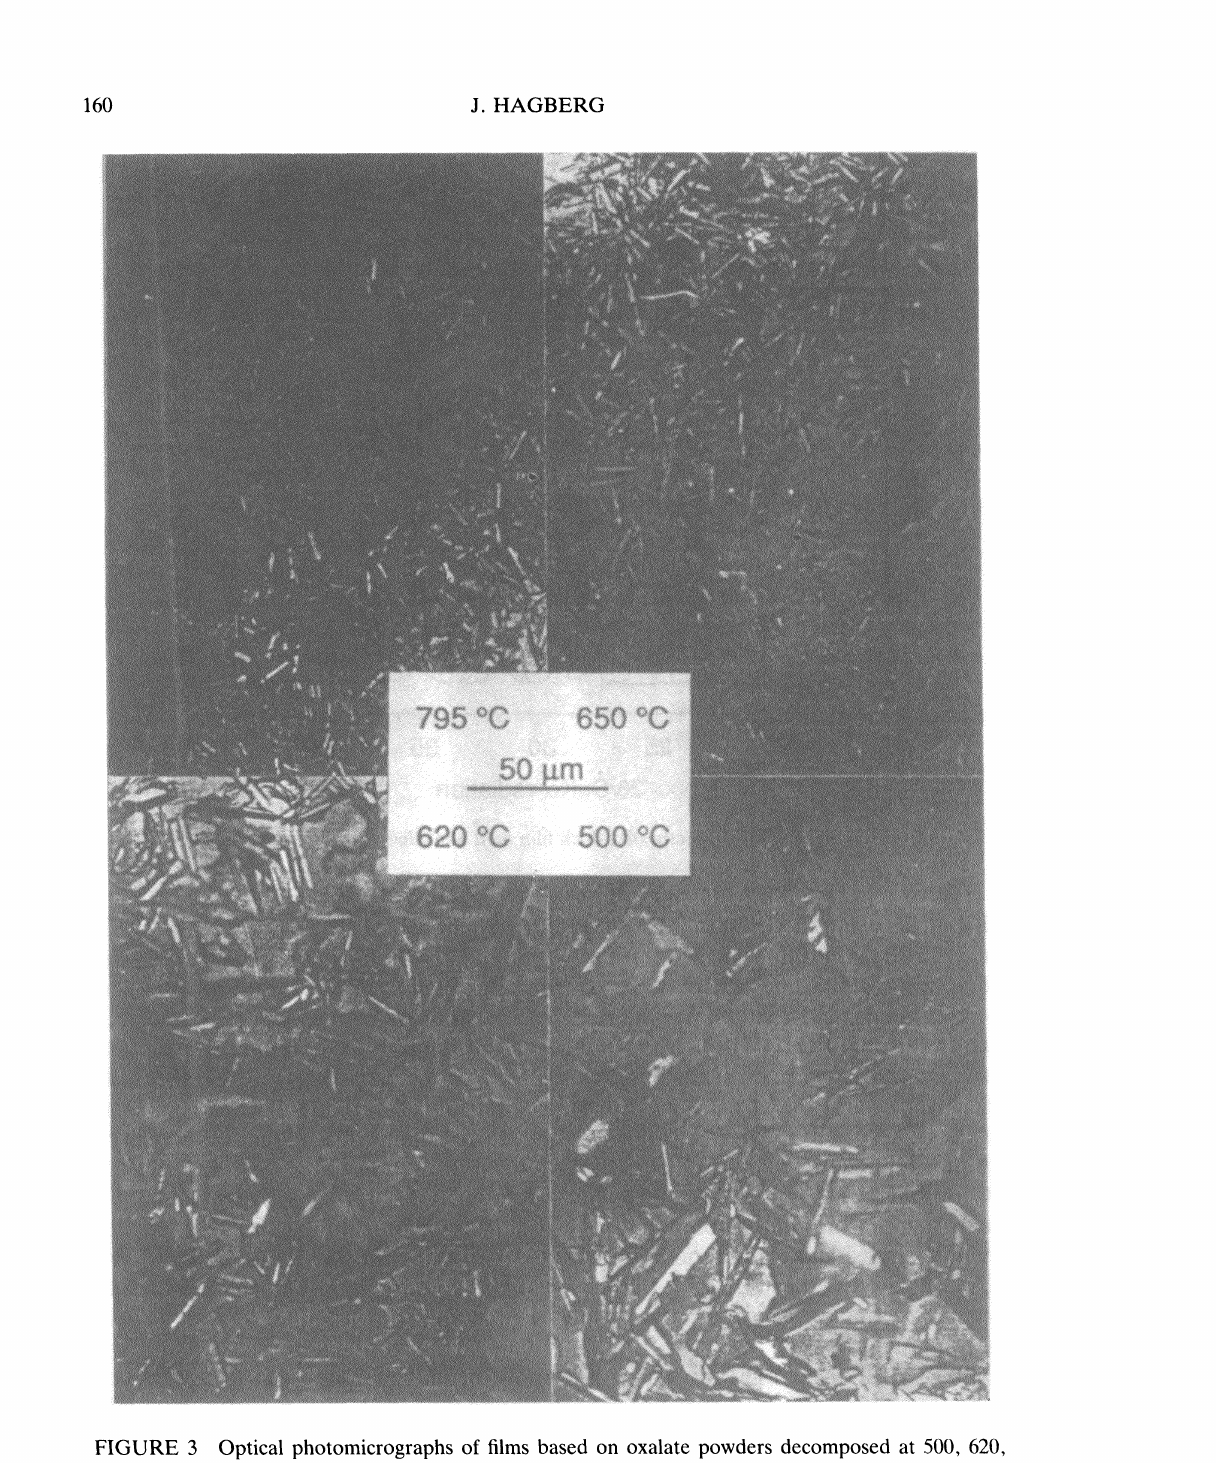
FIGURE 3 Optical photomicrographs of films based on oxalate powders decomposed at 500, 620, 659 and 795C and melted at 895C for 3 min. (Ca,Sr)2CuOy and some (Ca,Sr)laCu24041 grains in a (Bi,Pb)2Sr2CaCuzOy matrix can be